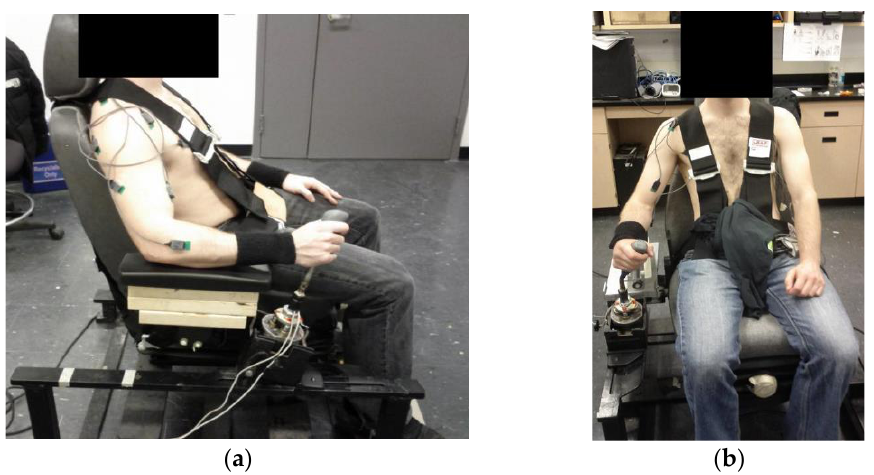
Figure 1. Participant setup for validation of a horizontally dynamic armrest, shown with stationary armrest ( a ) and dynamic armrest ( b ). Note that the level of the arm in the neutral joystick control position was adjusted to be approximately the same height for both armrest conditions.